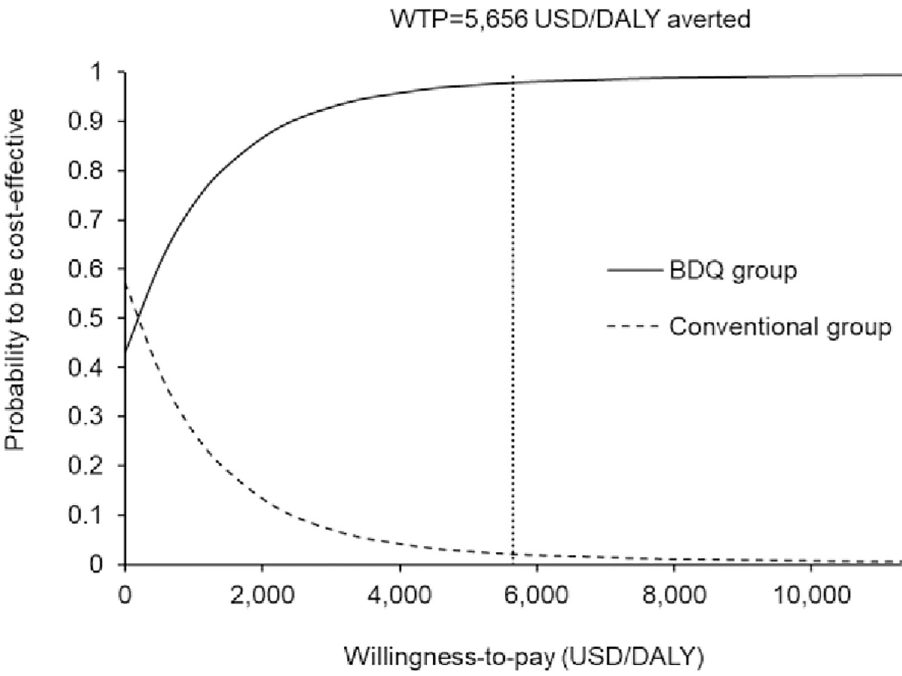
Fig 4. Acceptability curves of the BDQ group and the conventional group to be cost-effective against willingness- to-pay. BDQ: Bedaquiline; WTP: Willingness-to-pay.